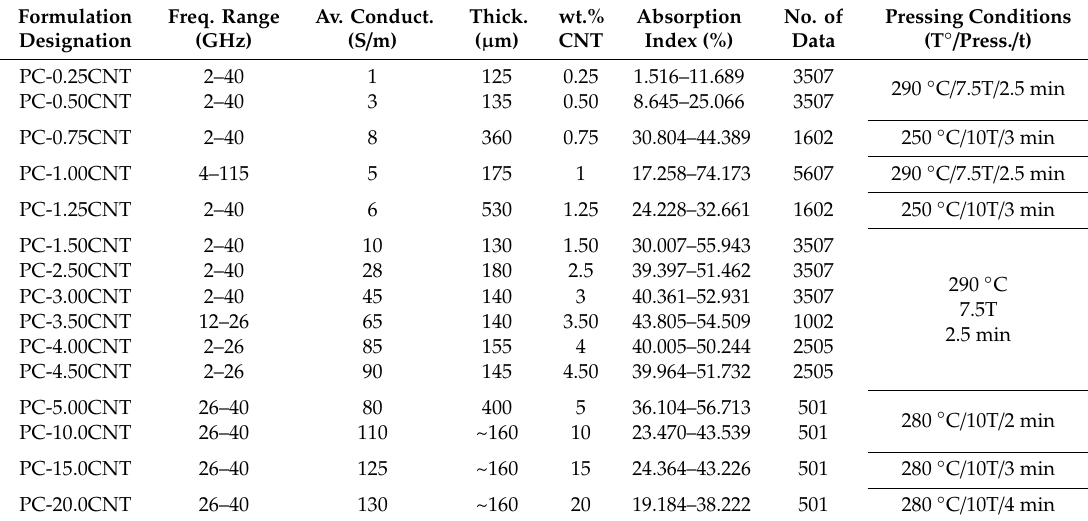
Table 1. Representation of the input and output data values of PC / CNT composites